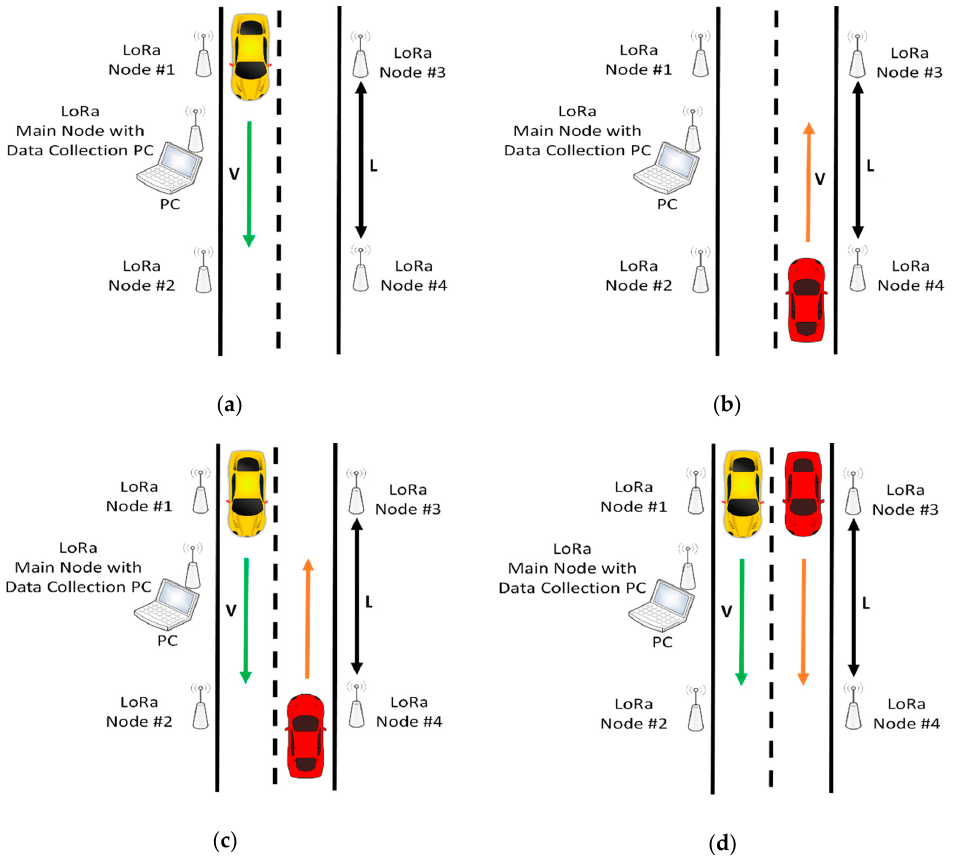
Figure 10. ( a ) One vehicle in one direction and its corresponding highway lane; ( b ) one vehicle in one direction and its corresponding highway lane in the opposite direction; ( c ) two cars in opposite directions; ( d ) two cars going the same way.